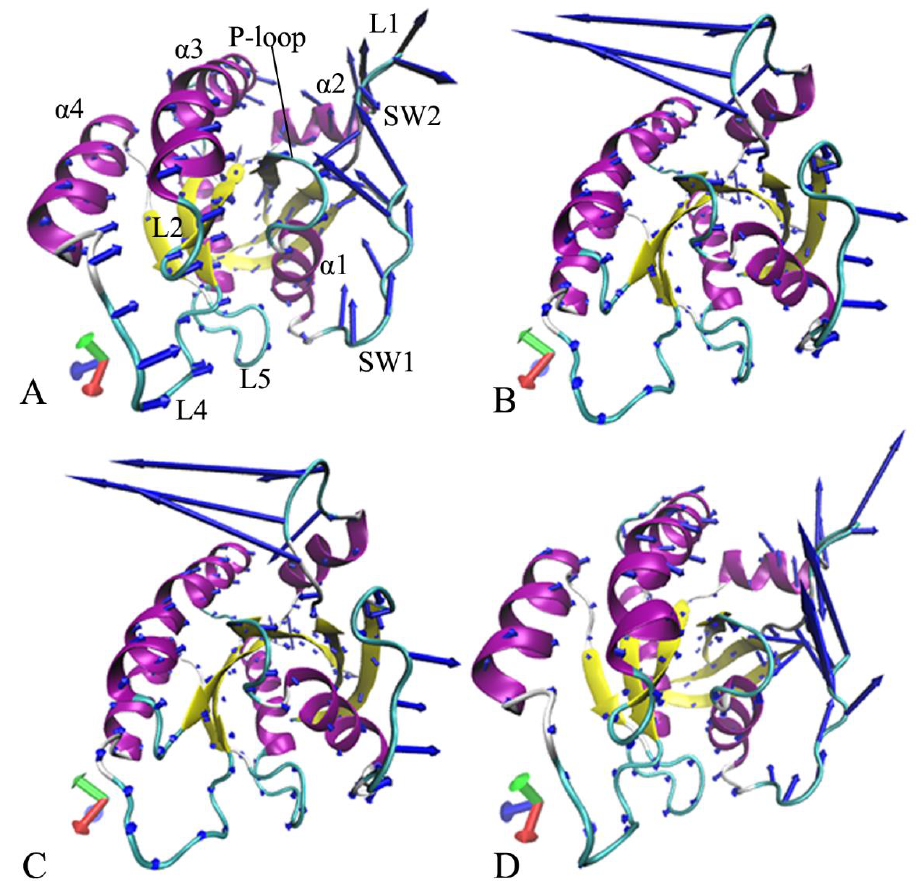
Figure 7. Concerted motions of the structural domains revealed by the first eigenvector arising from PCA: ( A ) the GDP-bound WT KRAS, ( B ) the GDP-bound G12A KRAS, ( C ) the GDP-bound G12D KRAS, and ( D ) the GDP-bound G12R KRAS. The violet, blue and cyan separately represent the helix, β- sheet and loop.